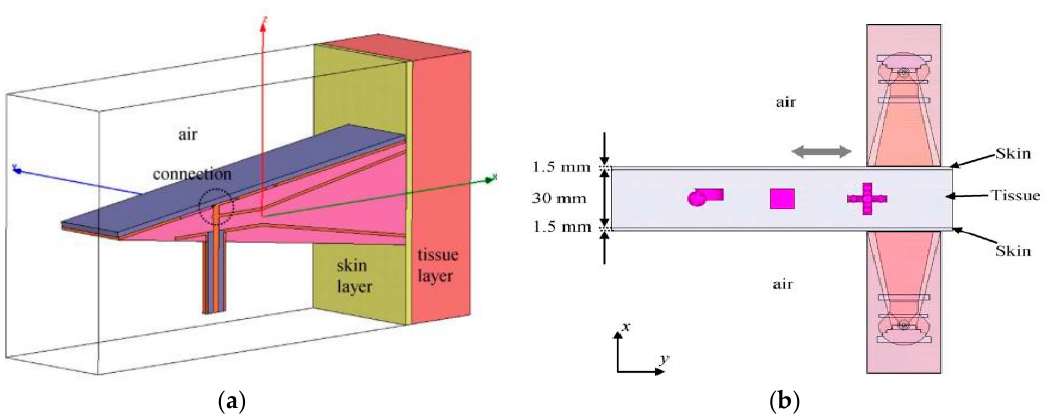
Figure 4. ( a ) Simulation setup of the antenna in a dielectric medium with microwave absorbing sheet on top surface ( b ) Imaging setup with compressed phantom and two antennas [55].